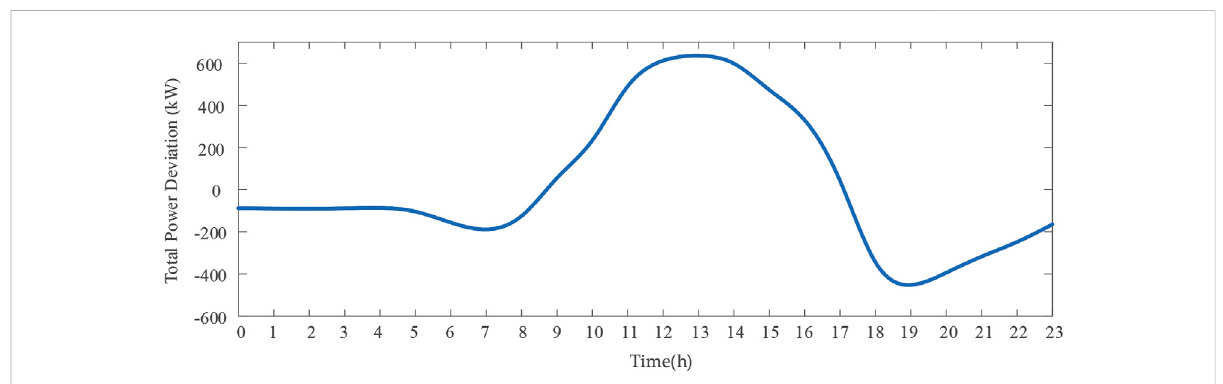
FIGURE 4 All-day power deviation curve.